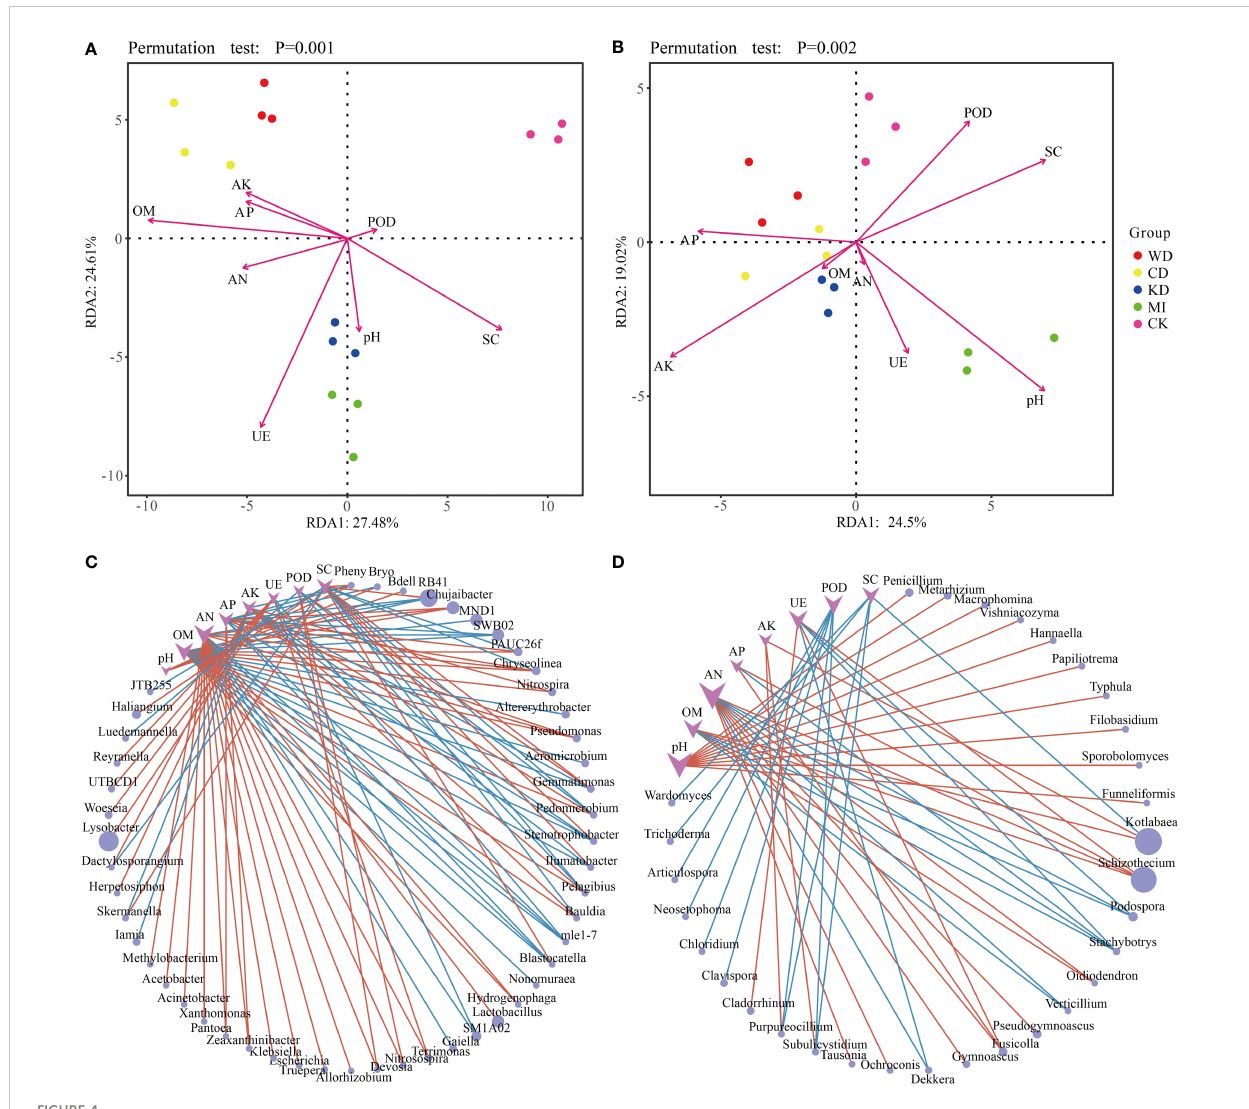
FIGURE 4 Statistical correlation of soil properties with the microbiome. Redundancy analysis (RDA) based on bacteria (A) and fungi (B) community composition of intercropping systems. Network analysis re fl ected the co-occurrence relationship between bacteria (C) and fungi (D) taxa and soil parameters. Purple vee nodes represent soil parameters. Grey ellipse nodes represent microbial members. Direct connections between nodes indicate strong correlations (Pearson correlation coef fi cient, ∣ r ∣ ≥ 0.5; P < 0.05). The color of the edges represents positive correlation (pink) or negative correlation (blue). The sizes of vee nodes are proportional to the interconnected degree. The sizes of ellipse nodes are proportional to the relative abundance. AN, available nitrogen; AP, available phosphorus; AK, available potassium; OM, organic matter. UE, urease; POD, peroxidase; SC, sucrase. WD, watermelon-daylily intercropping; CD, cabbage-daylily intercropping; KD, kale-daylily intercropping; MI, row mixed intercropping, watermelon, cabbage, and kale were alternately intercropped with daylily; CK, monoculture